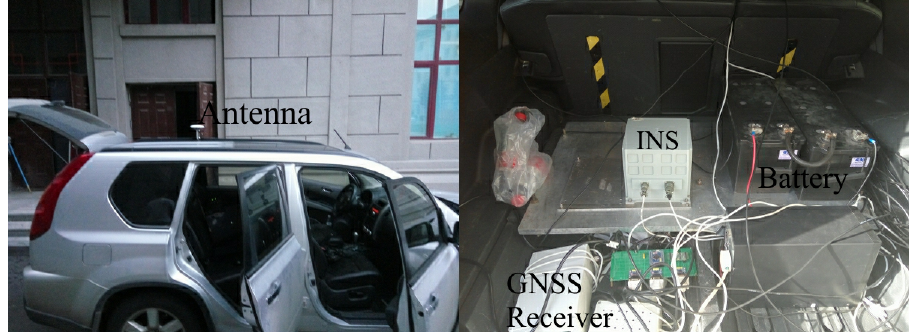
Figure 5. Equipment for the vehicular dynamic test. Both GPS and BDS were employed in this experiment, and the number of observed satellites was the sum of that of two systems. Figure 6 shows the positional dilution of precision (PDOP) and the number of satellites visible during the test. The average of the PDOP was 2.02, and the average number of observed satellites was 10.67.